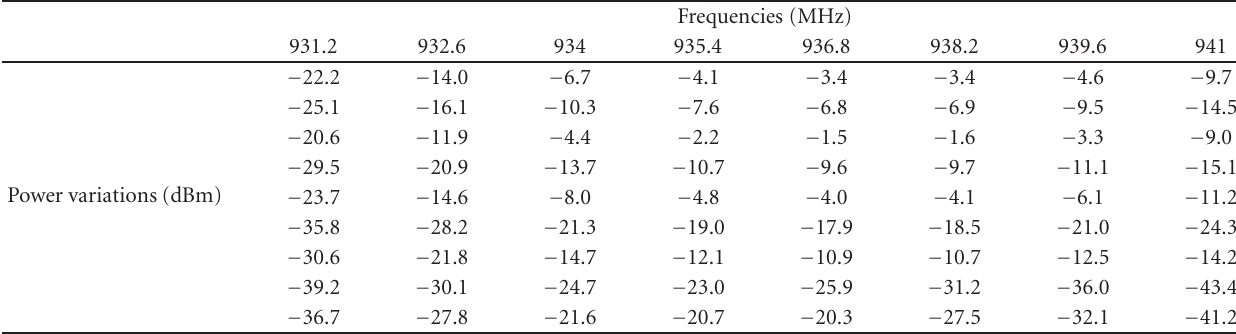
Table 1: Spectrum variations at di ff erent time instances.